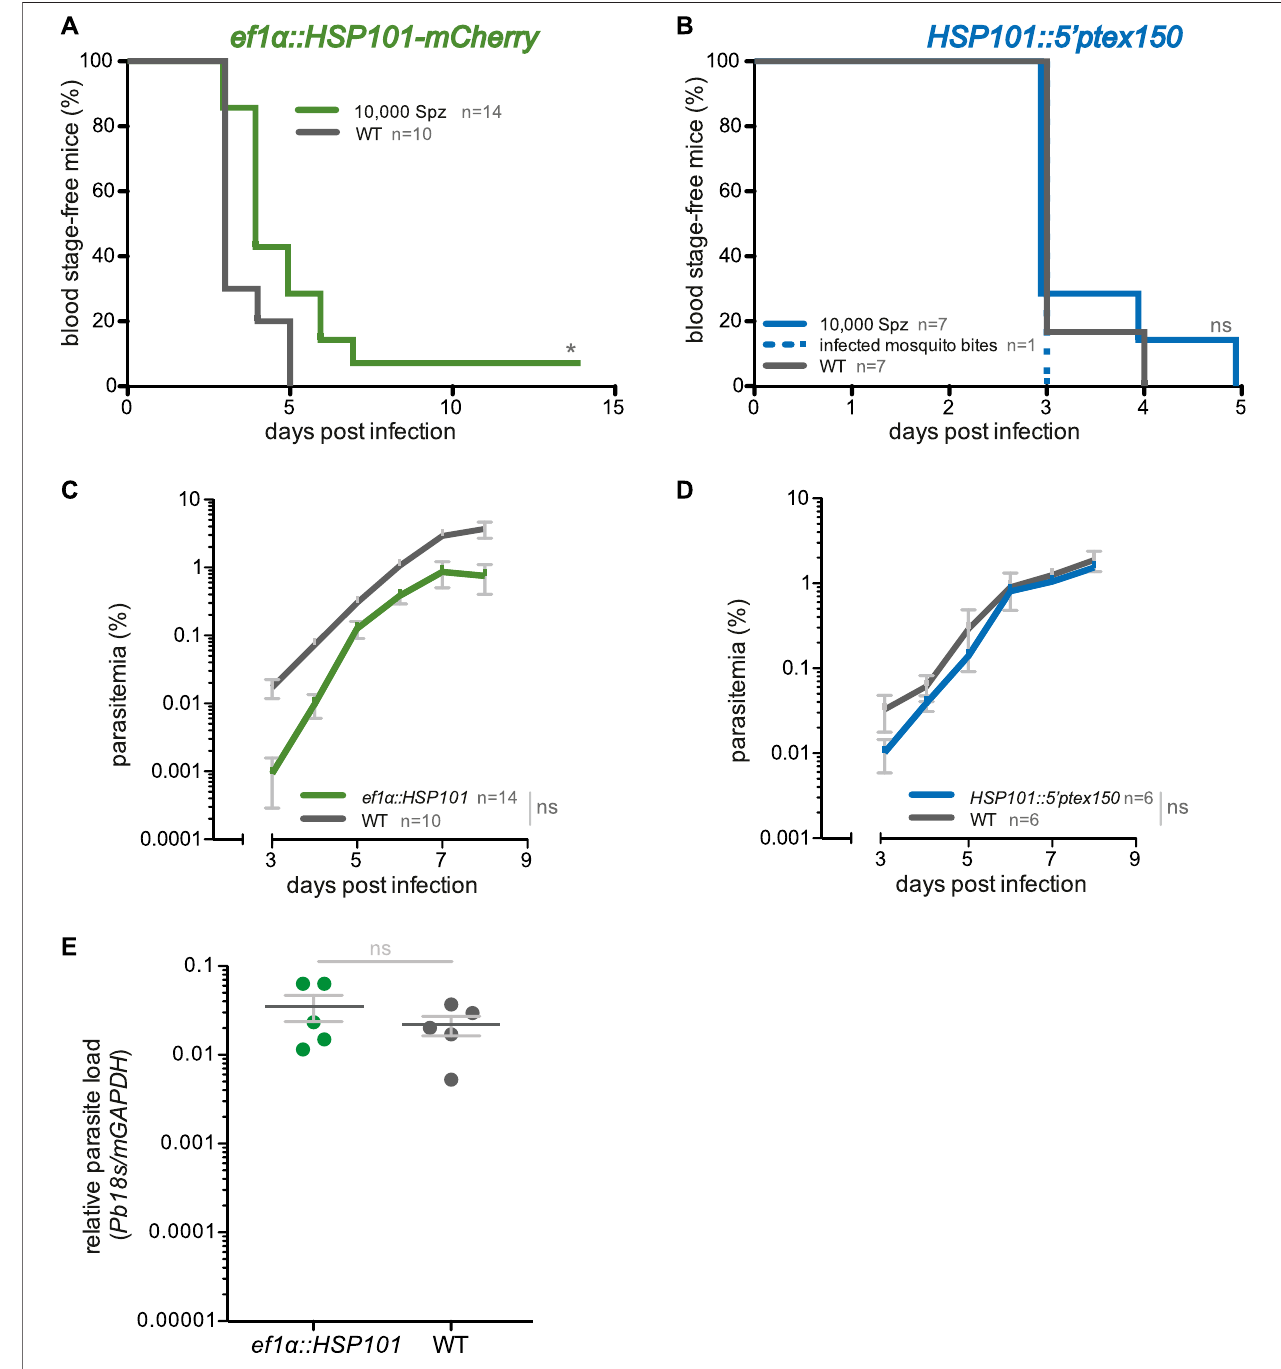
FIGURE 2 | Blood infections induced by ef1 α :HSP101-mCherry and hsp101:5 ′ ptex150 sporozoites. (A,B) Shown are Kaplan-Meier analyses of blood infection over timeafter intravenousinjection of10,000sporozoitesisolatedfrom (A) ef1 α :HSP101-mcherry or (B) hsp101:5 ′ ptex150 -infected Anophelesstephensi mosquitoes. Exposure to 15 hsp101:5 ′ ptex150 -infected mosquitoes is included in (B) . (C,D) Blood stage growth in (C) ef1 α :HSP101-mCherry or (D) hsp101:5 ′ ptex150 -infected mice. (E) qPCR analysis of relative parasite liver load 48 h after sporozoite infection. Shown are mean values ( ± SD). Blood infection was monitored daily by microscopic examination of Giemsa-stained blood fi lms. *, p < 0.05; n. s., non-signi fi cant (Log rank test for Kaplan-Meier analysis and slope analysis; Mann-Whitney-U test for relative parasite liver load).